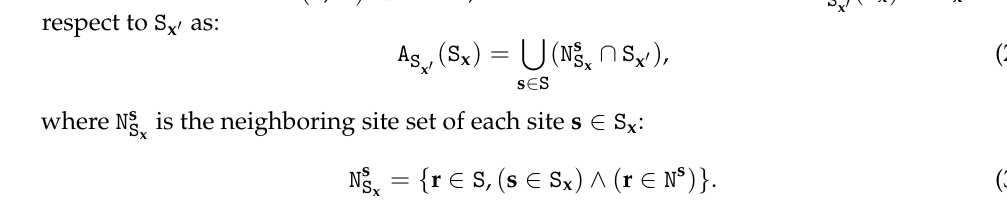
( S ) (circles) and A B G ( S ) ( 1 ) and A 1 B G